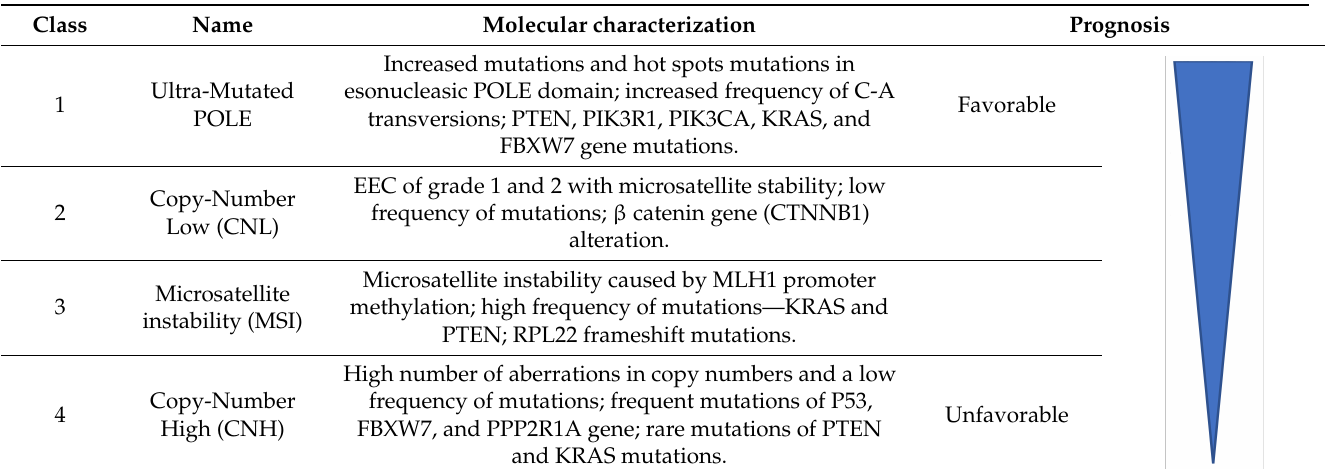
Table 1. Four classes of endometrial cancer according to